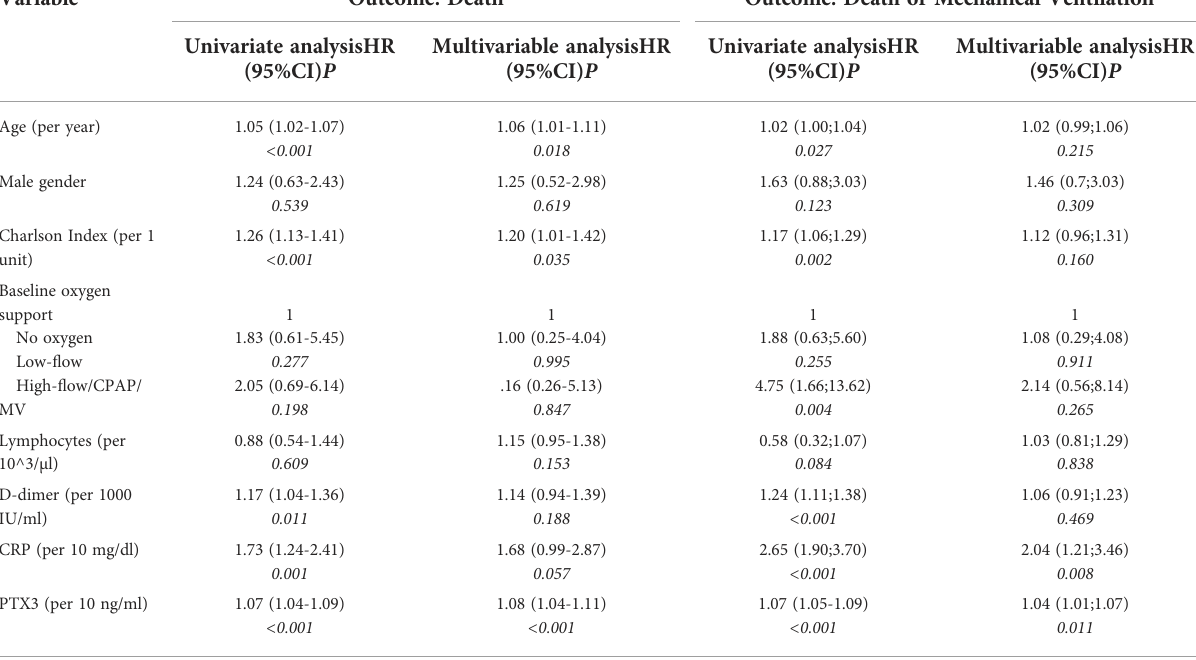
TABLE 2 Uni- and multivariable cause-speci fi c Cox regression models for the two endpoints of interest. Variable